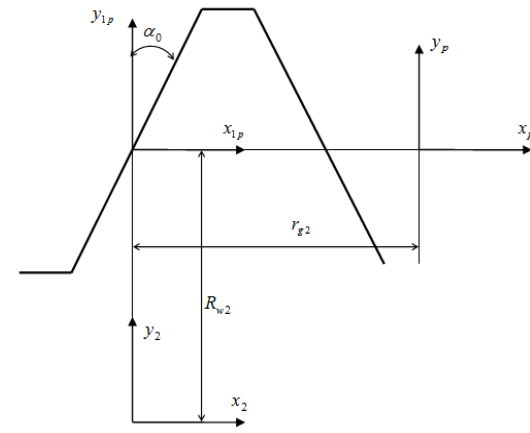
Figure 3. Coordinate systems to define elements of matrix A p ,2